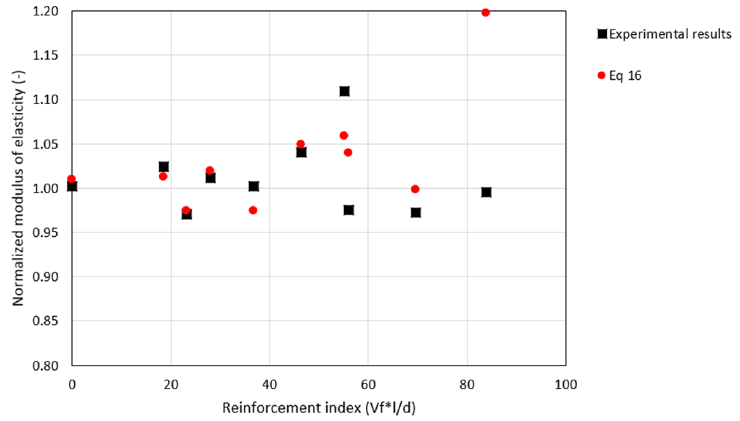
Figure 23. Normalized comparison between modulus of elasticity prediction equations based on UPV.